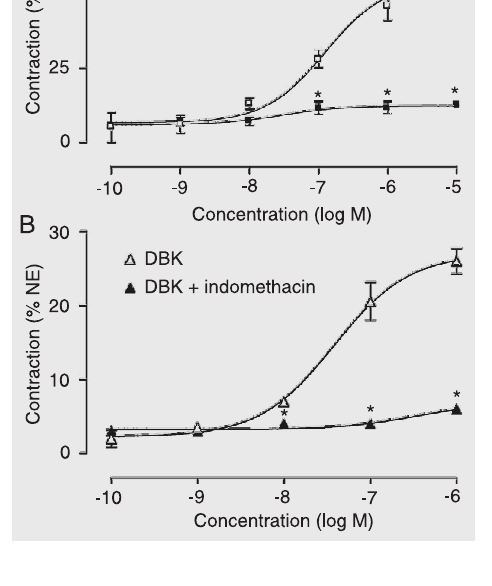
Figure 5. Sodium nitroprusside- induced relaxation in norepi- nephrine-precontracted rings of mouse aorta. Percent relaxation was calculated from the steady- state tension induced by norepi- nephrine. Data are reported as means ± SD of 5 independent